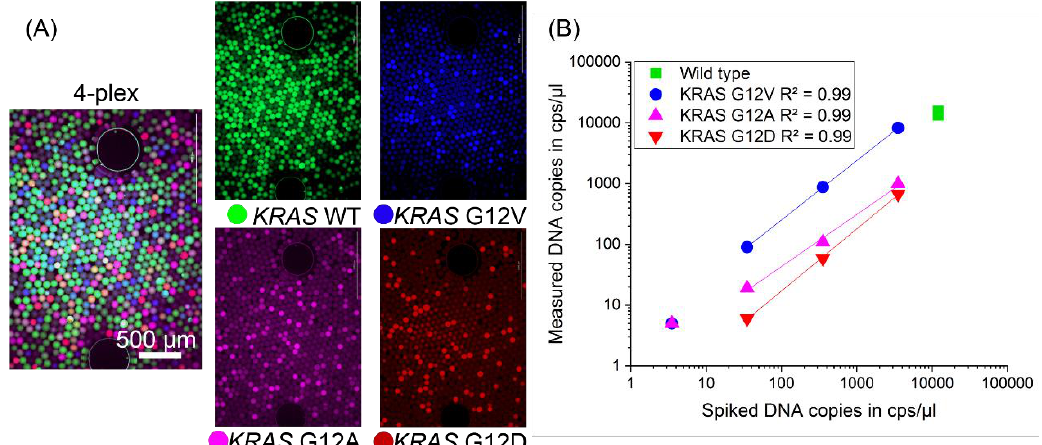
Figure 5. ( A ) Fluorescence image overlay of the four-plex ddPCR assay for the KRAS wild type (WT) and the point mutations KRAS G12D, G12V and G12A. Individual fluorescence images show amplification signals in all three color channels for the mutant DNA and in the fourth color channel for the wild type DNA. ( B ) The proof-of-concept serial dilution experiment showed the high reaction linearity of the four-plex ddPCR assay inside the LabDisk across 3540–35 mutant DNA copies per µL. The lowest dilution point (3.5 mutant DNA copies per µL) was quantifiable for KRAS G12V and G12A, but not for G12D.